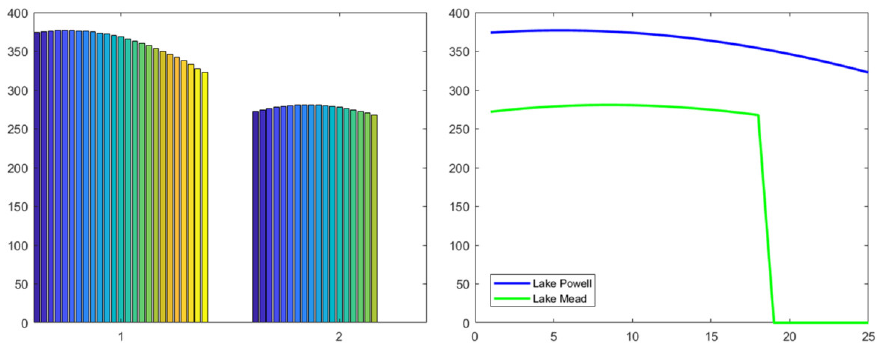
Figure 3. Water level change curves of two reservoirs.